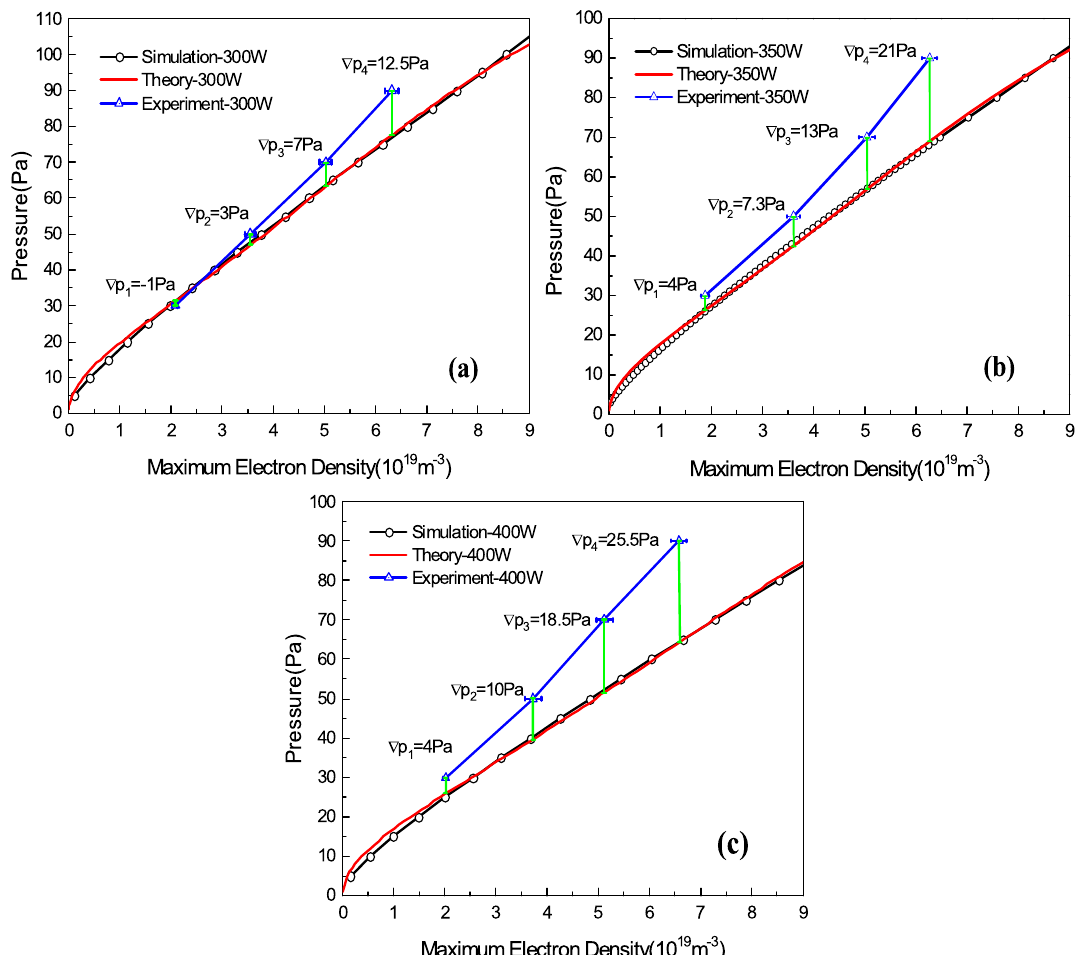
Figure 6. Pressure calibrations at 300 W ( a ), 350 W ( b ) and 400 W ( c ) absorbed